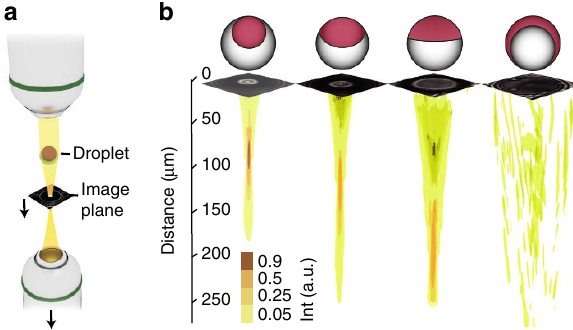
Figure 2 | Variable focusing. ( a ) Schematic of the setup used to record the light field behind the droplets. The bottom objective scans through the z -direction. ( b ) Iso-surfaces of the reconstructed light fields behind the droplets for different internal droplet morphologies. Representative image data sets captured immediately behind the droplets show slices of the scan, from which the light field was reconstructed. Droplet sketches are offset upwards by 10 m m to not obstruct slice